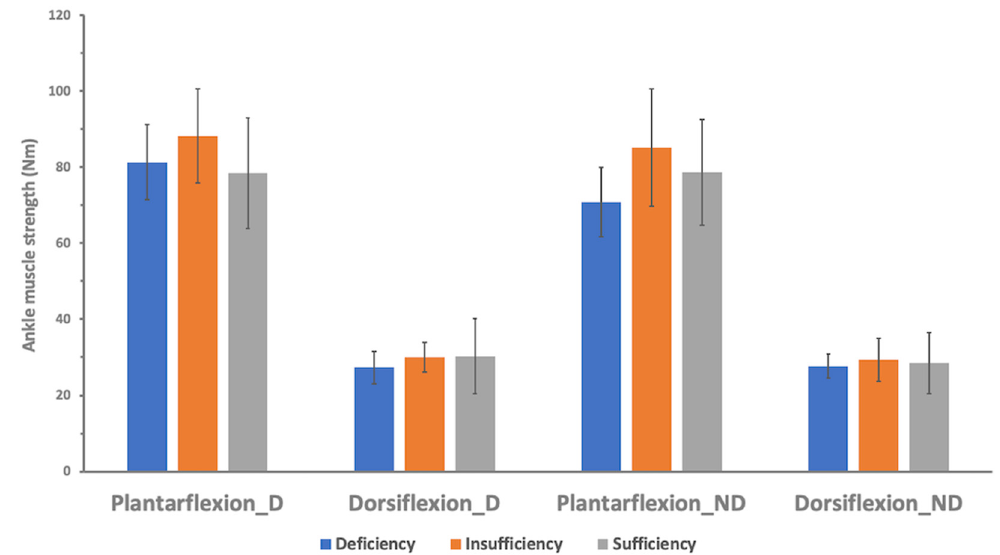
Figure 2. Isokinetic ankle muscle strength at 30 ° / s according to vitamin D status. The isokinetic ankle strengths were not significantly di ff erent across the three groups in all settings (Plantarflexion_D, ankle plantarflexion at dominant side; Dorsiflexion_D, ankle dorsiflexion at dominant side; Plantarflexion_ND, ankle plantarflexion at non-dominant side; Dorsiflexion_D, ankle dorsiflexion at non-dominant side).